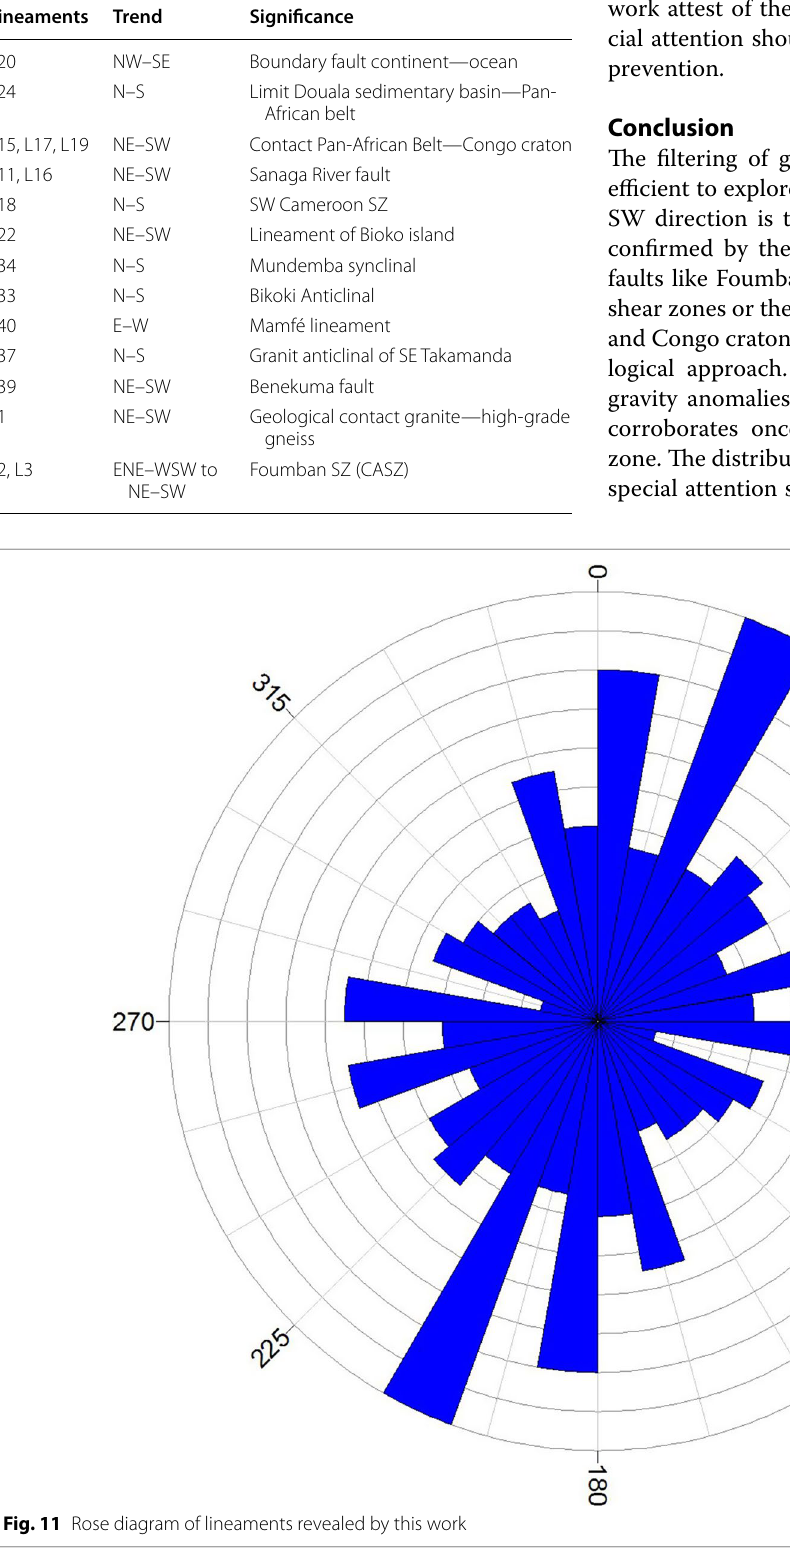
Table 2 Summary of main lineaments identified in the